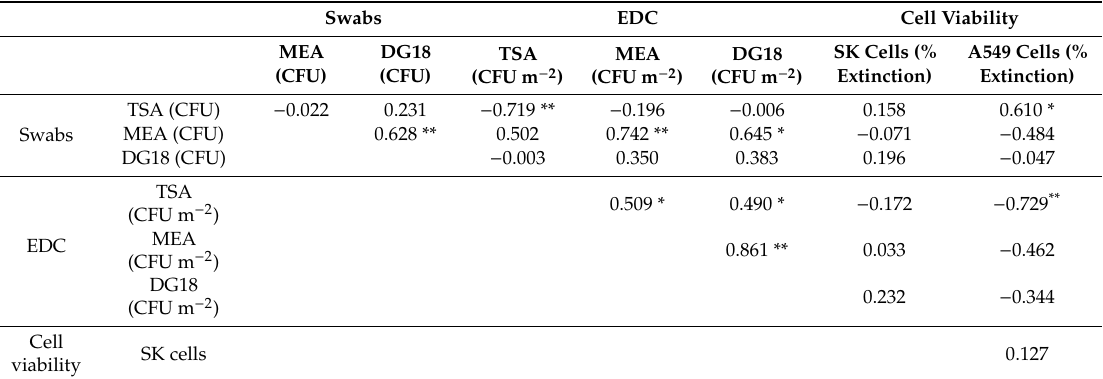
Table 8. Study of the relationship between microbial contamination and cell viability (MTT assay) (Spearman correlation coe ffi cient